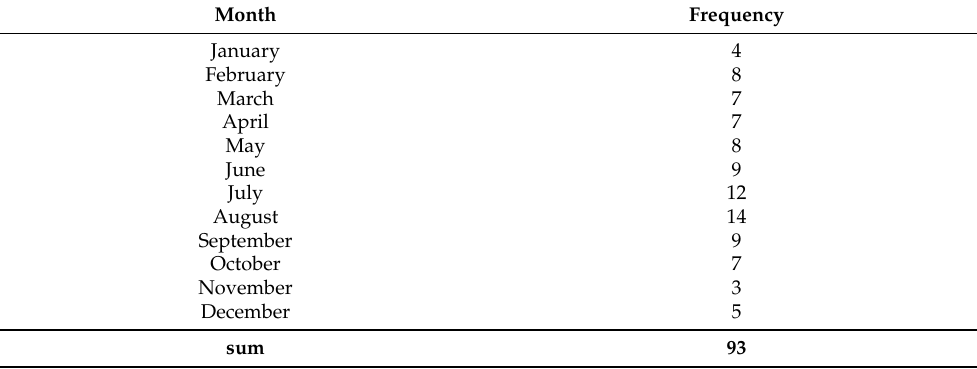
Table A2. Distribution of selected Sentinel-2 images, by month.